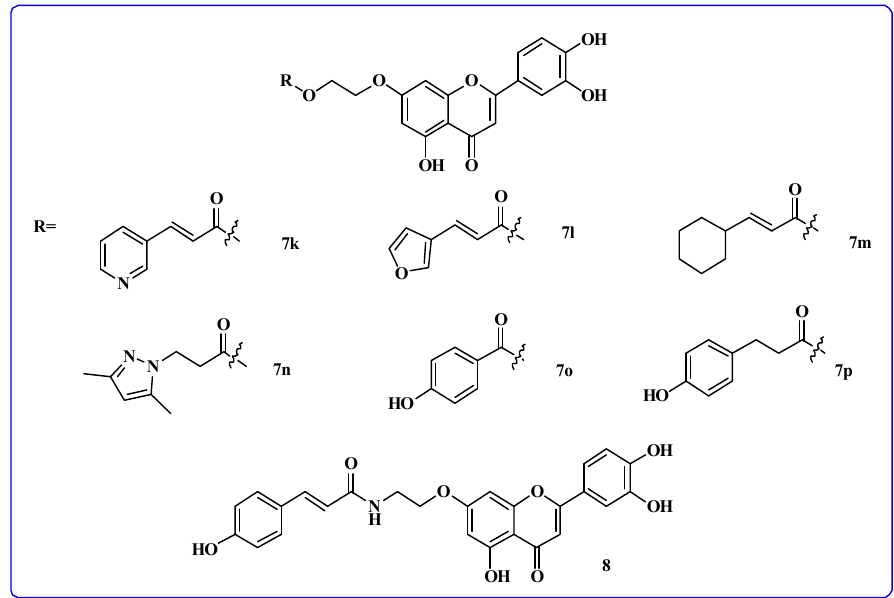
Figure 5. The structure of compound 7k – 7p and 8 .